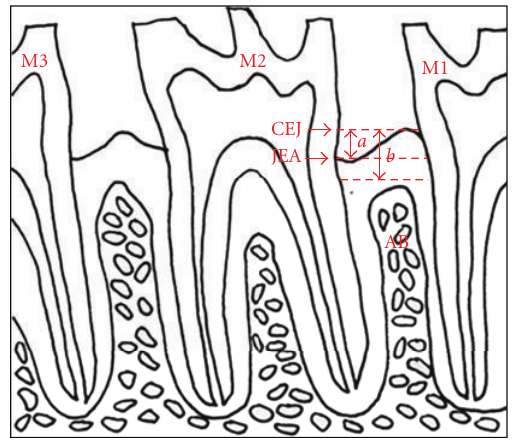
Figure 1: Schematic illustration of the histometric parameters evaluated. M1: maxillary first molar; M2: maxillary second molar; M3: maxillary third molar; CEJ: cement-enamel junction; JEA: junctional epithelial attachment; AB: alveolar bone; a : attachment loss; b : alveolar bone loss.